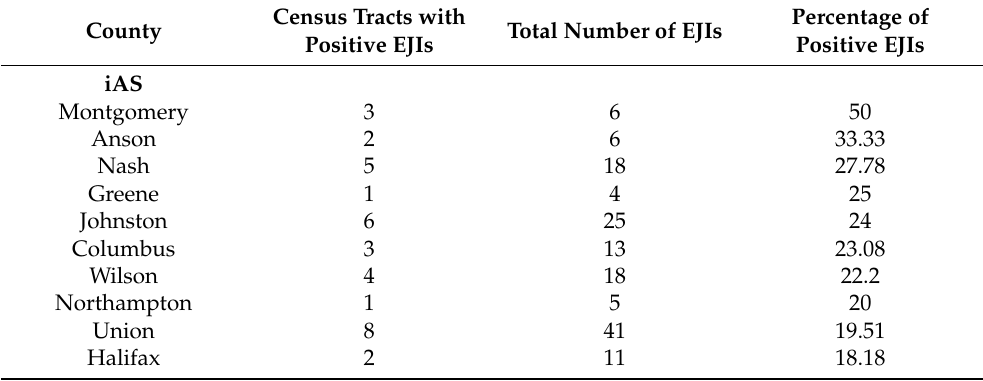
Table 2. Counties with the ten highest percentages of positive